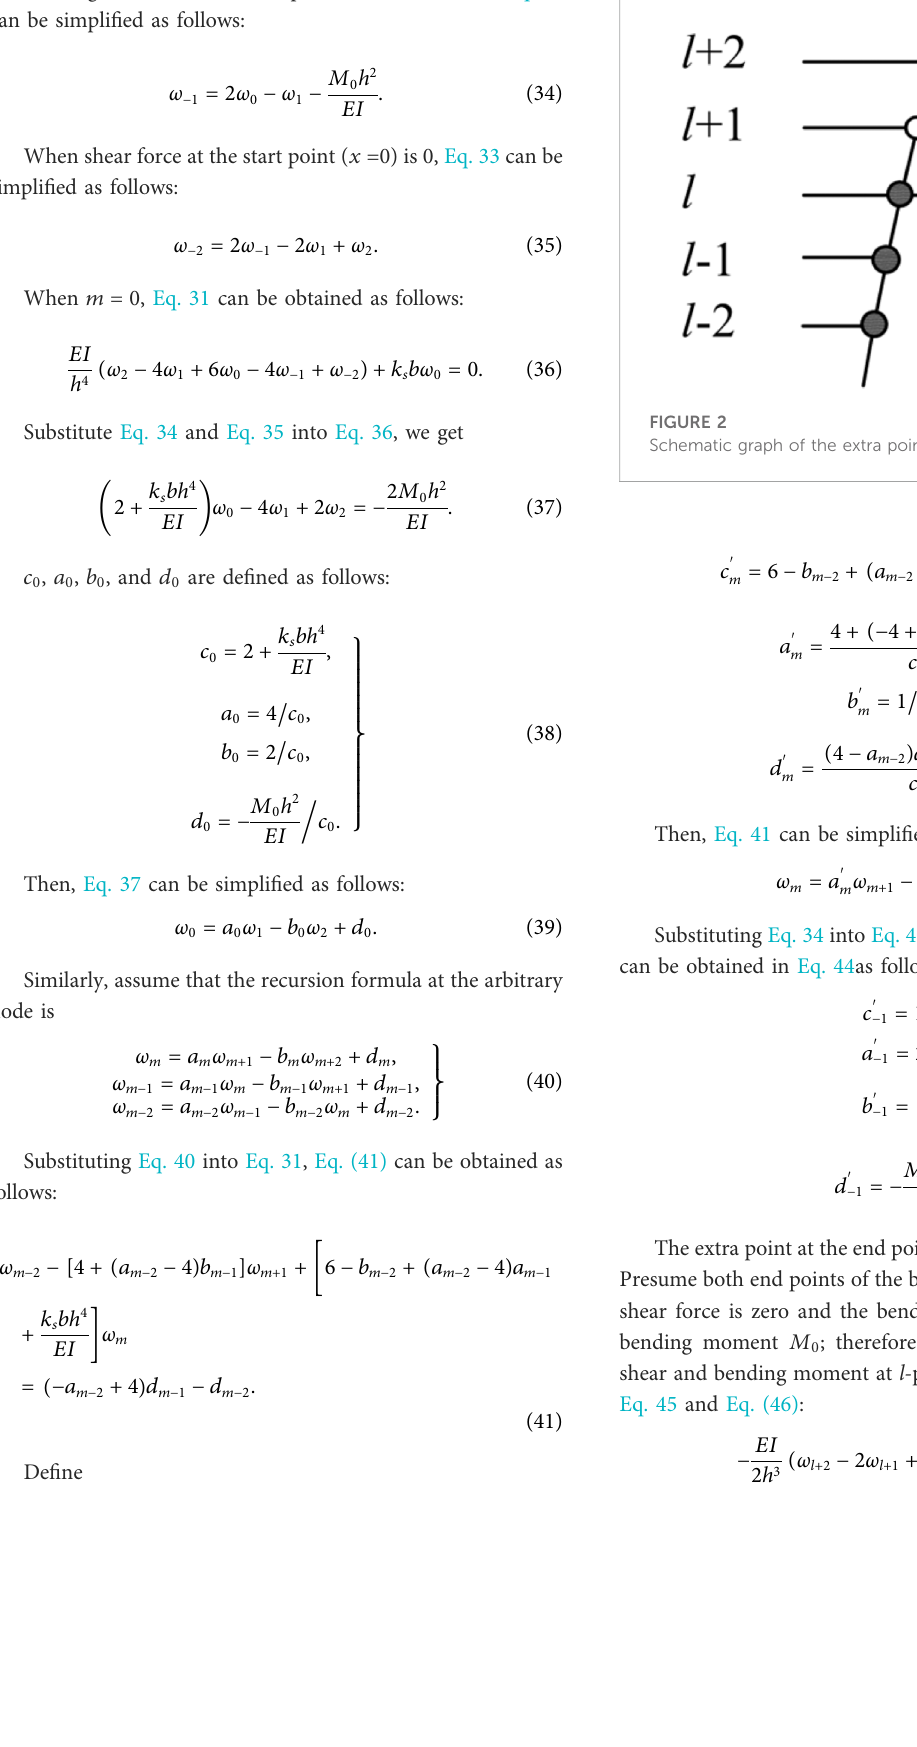
FIGURE 2 Schematic graph of the extra